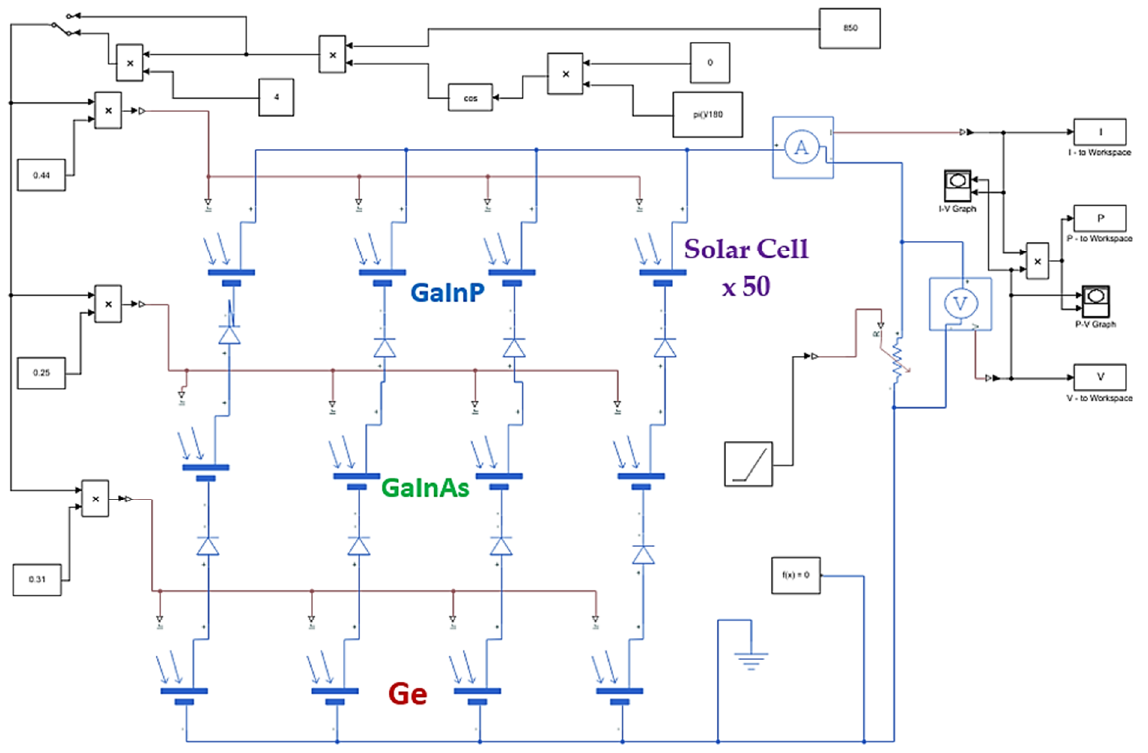
Figure 4. The simulation model of the C3PV module in Matlab/Simulink.